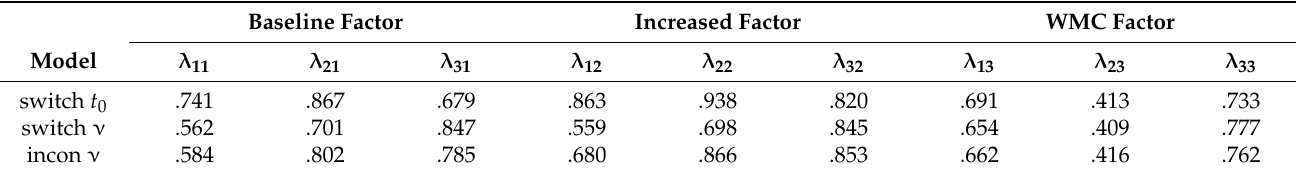
Table A1. Factor loadings of LDS measurement models for DM parameters.